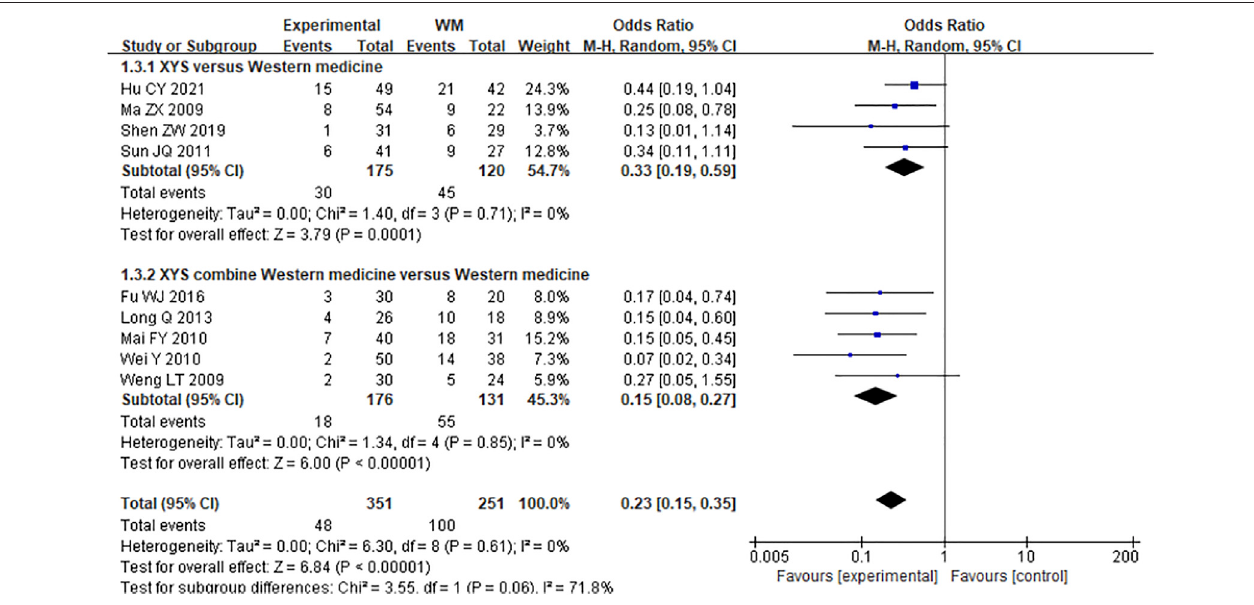
FIGURE 7 | Forest plot of comparison of recurrence rate. WM, western